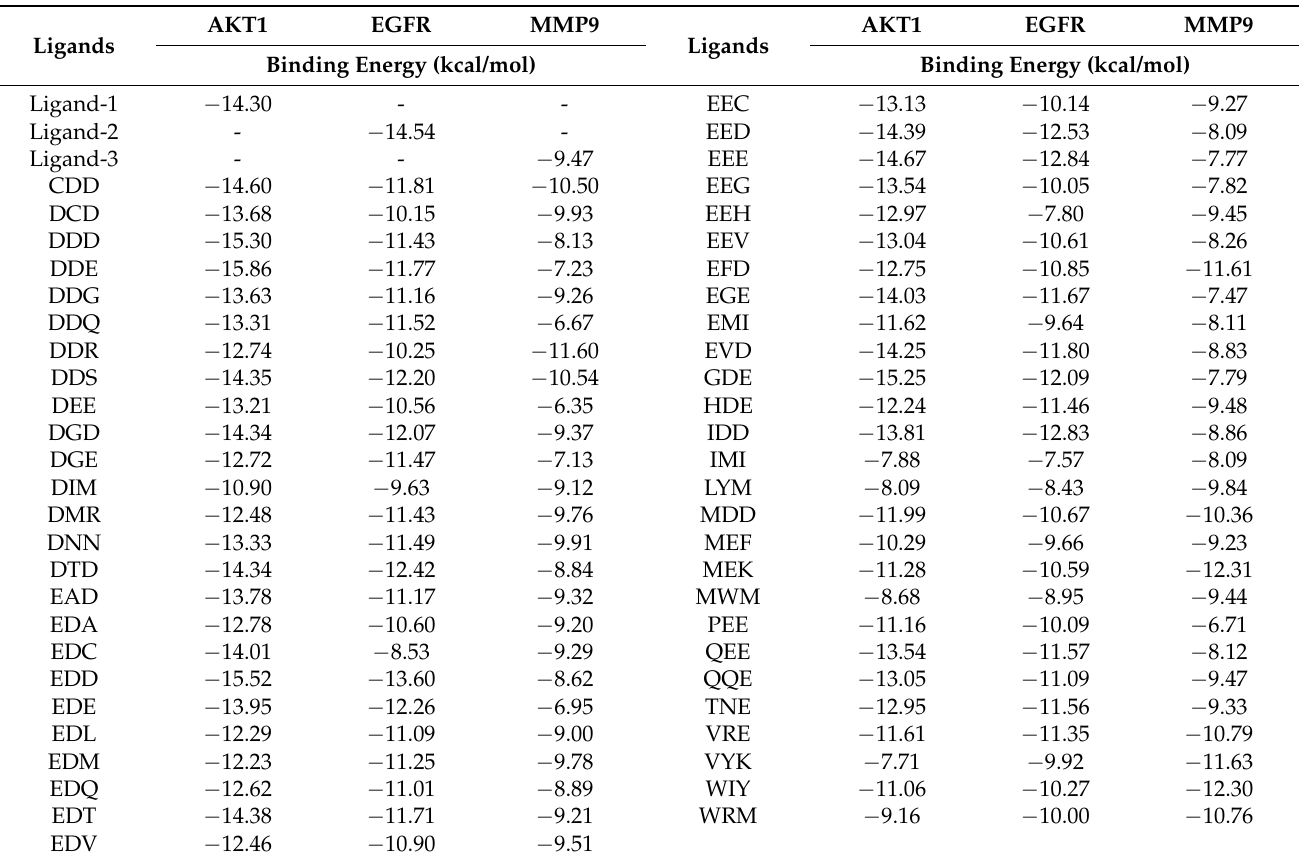
Table 3. Binding free energy of ligand-tripeptides